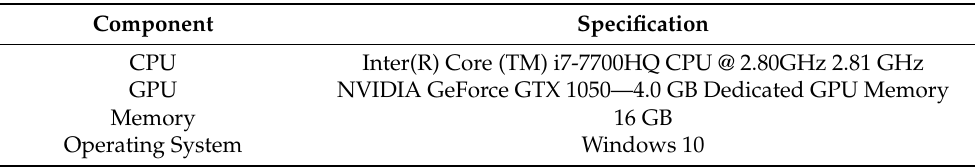
Table 7. Experimental-environment specifications.